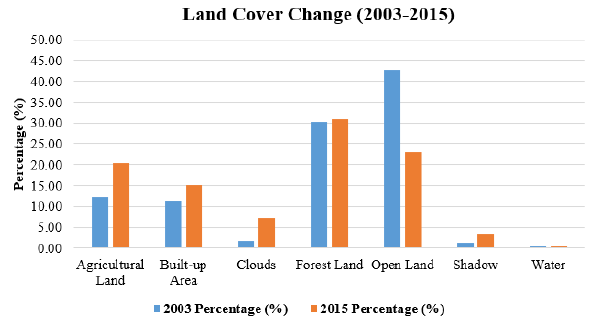
Figure 3. Bar graph showing the percentage of each land cover